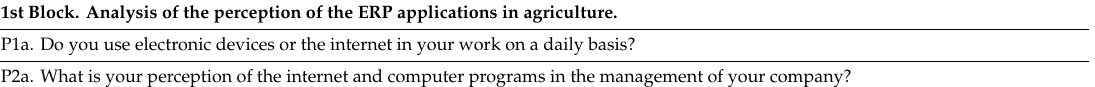
Table 1. Questionnaire answered by farmers, technicians, and